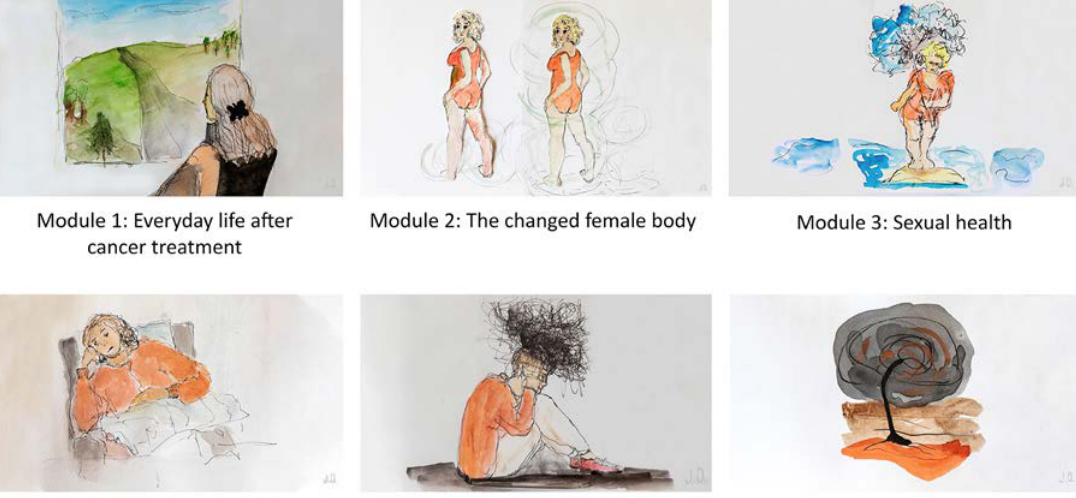
Figure 2. The program’s six modules.